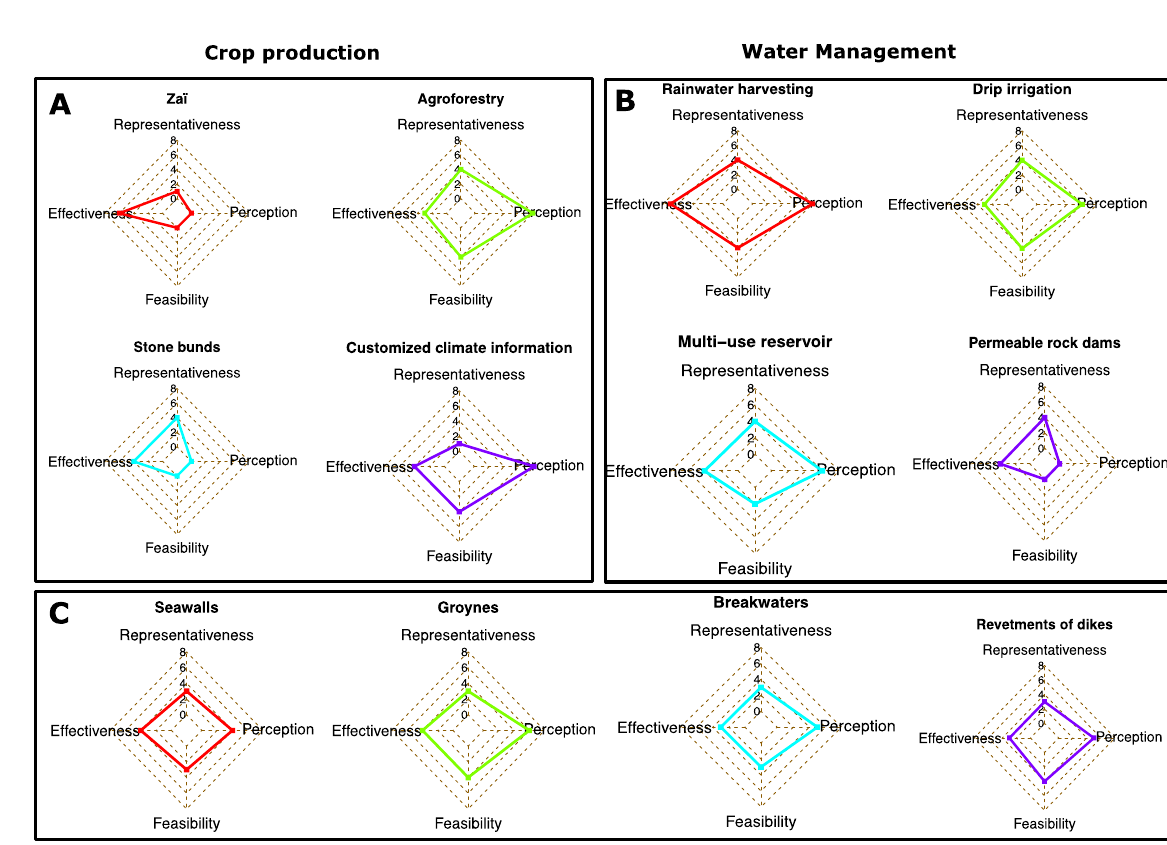
Figure 3. High-scoring adaptation options and measures suitable for crop production and soil water conservation ( A ), water resources management ( B ), and the protection of coastal zones ( C ) of West Africa under climate